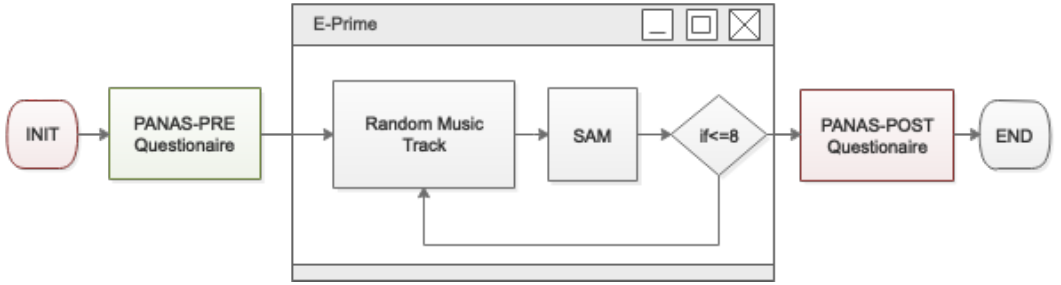
Figure 3. Experiment